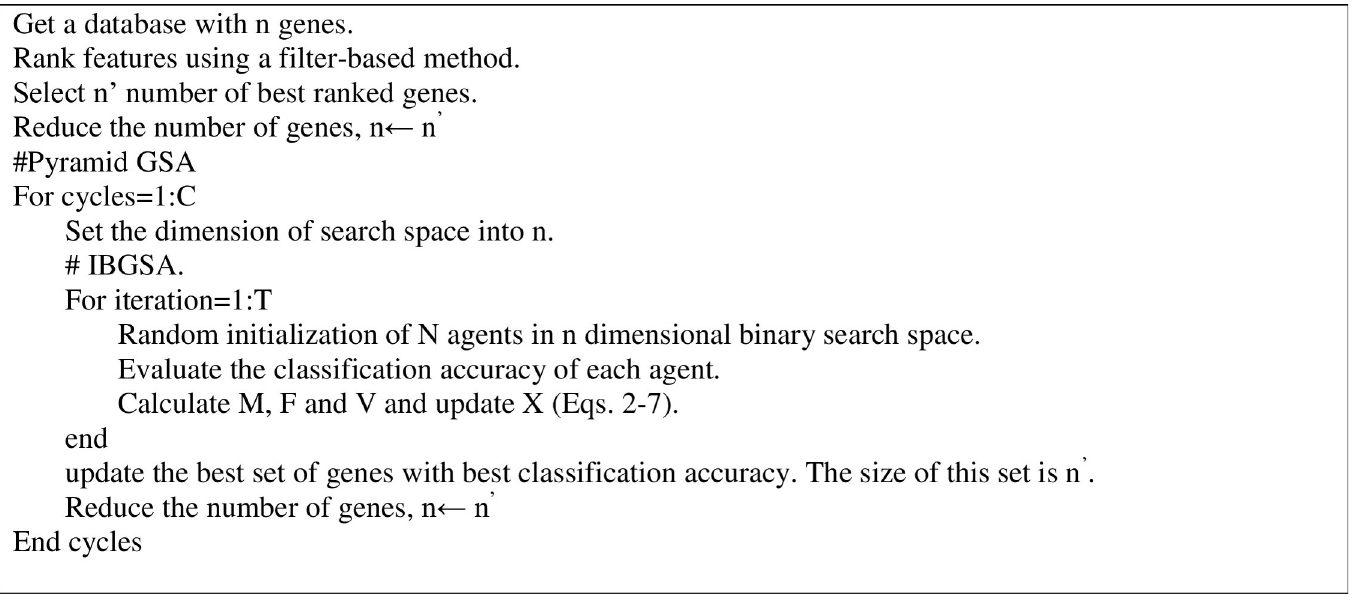
Fig 2. Pseudo code of gene selection using pyramid